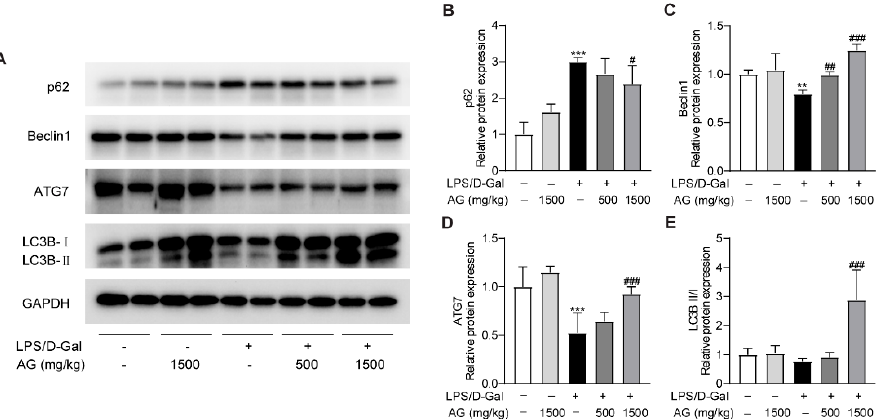
Figure 6. Effect of Ala-Gln on autophagy in liver in LPS/D-Gal-treated mice. ( A ) Protein expression levels of p62, Beclin-1, ATG-7, and LC3B in liver were assessed using Western blot. ( B – E ) Quantitation of p62, Beclin-1, ATG-7, and LC3B-II/I expression. Data are expressed as mean ± SD, n = 6–8 in each group. ** p < 0.01, *** p < 0.001 vs. vehicle-treated control group, # p < 0.05, ## p < 0.01, ### p < 0.001 vs. LPS/D-Gal-treated model group.